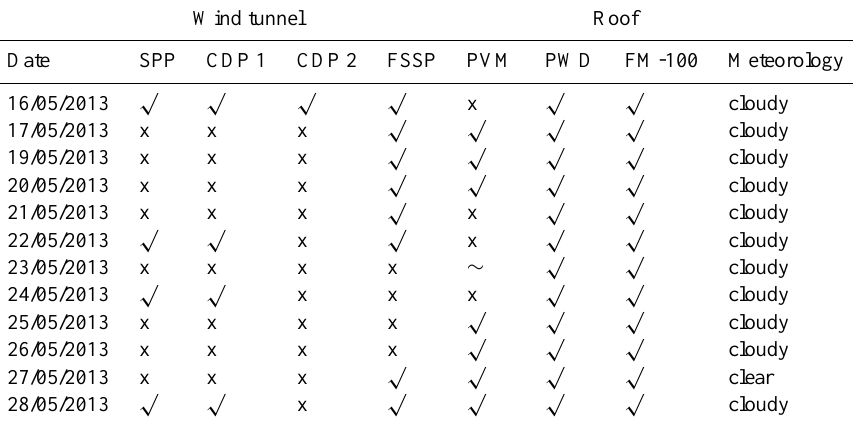
Table 1. Data availability for each instrument used during